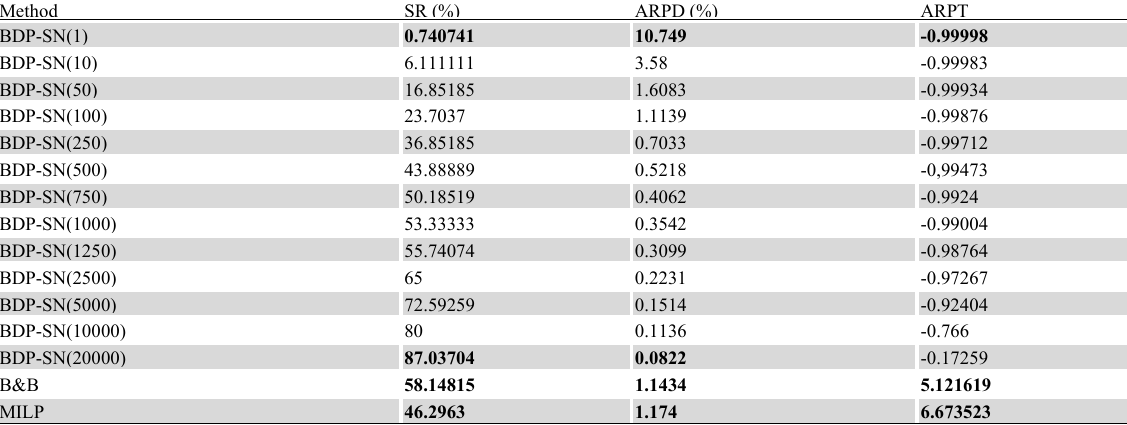
General data for the first experimental